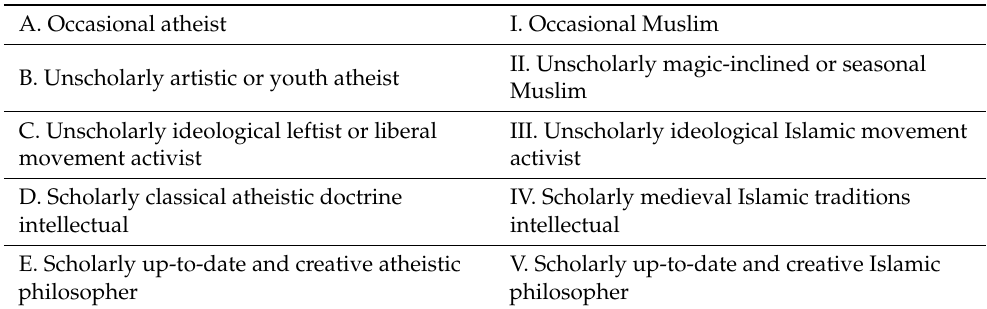
Table 1. The five Islamic-atheistic